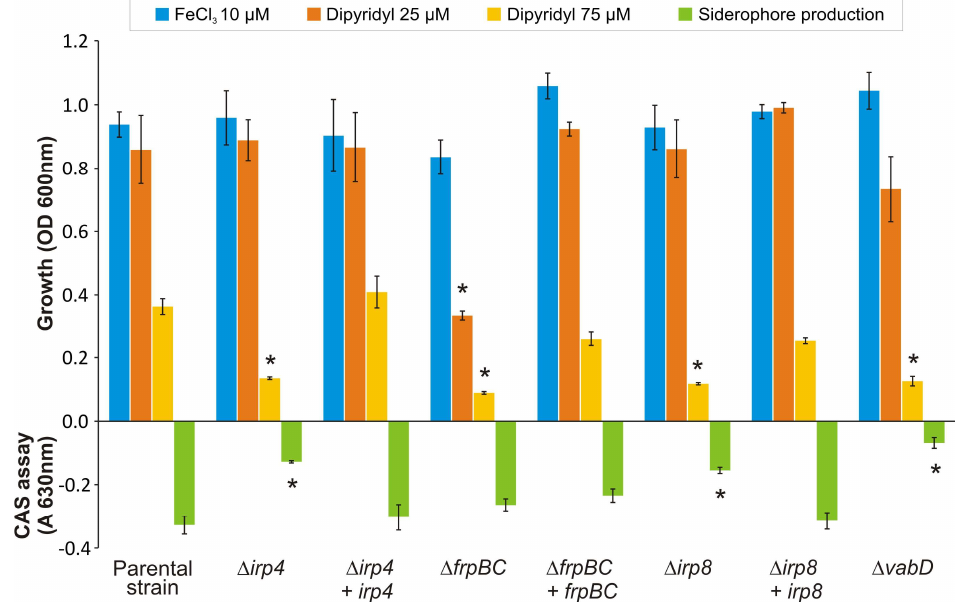
Figure 2. The growth of V. anguillarum parental strain (RV22 Δ vabF ) and its derivative mutants under iron excess (10 µM FeCl 3 ) and iron-restrictive (25–75 µM 2,2′-dipyridyl) conditions. Siderophore production was quantified by CAS liquid assay in cell-free supernatants of cultures grown in CM9 supplemented with 25 µM 2,2′-dipyridyl. Uninoculated CM9 with 25 µM 2,2′-dipyridyl was used as blank. Asterisk denotes statistically significant differences, p < 0.05 (student’s t -test).